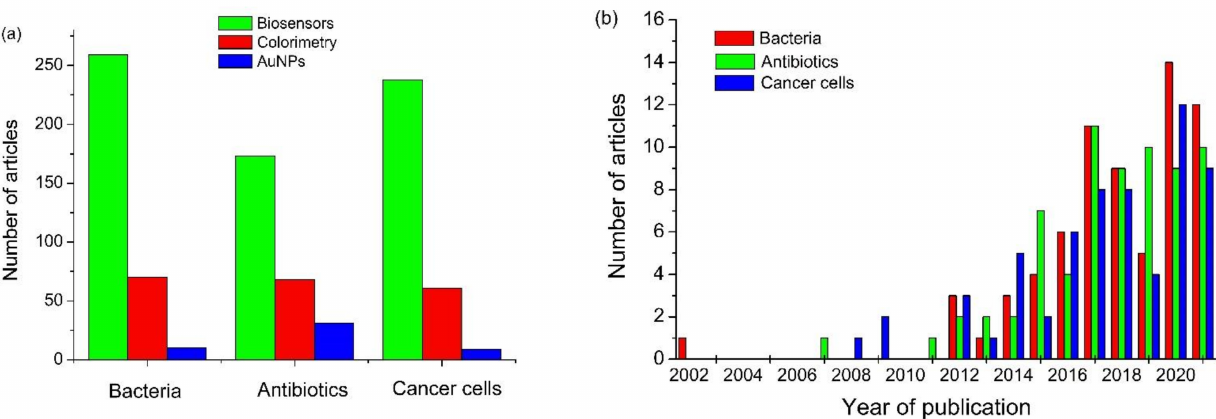
Figure 15. The statistics based on the Scopus database on the number of articles focused on ( a ) aptamer-based biosensors, colorimetric assay and colorimetric assay based on AuNPs for the detection of bacteria, antibiotics and cancer cells. ( b ) Aptamer-based colorimetric assay for the detection of bacteria, antibiotics and cancer cells (according to the Scopus database, www.scopus.com, accessed on 25 September